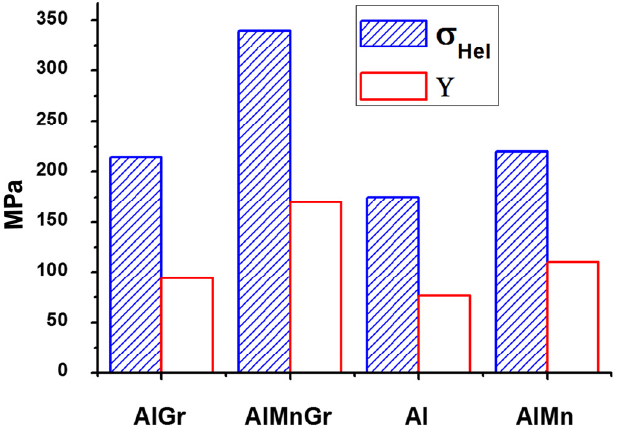
Figure 12. Dynamic properties of SMC composites and their SMC unreinforced analogs.